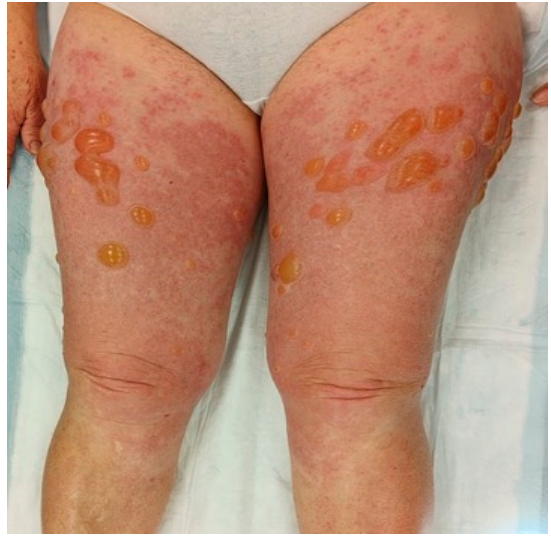
Figure 2. Clinical presentation of bullous pemphigoid showing tense bullae with a clear content overlying wheal-and-flare plaques on lower limbs.